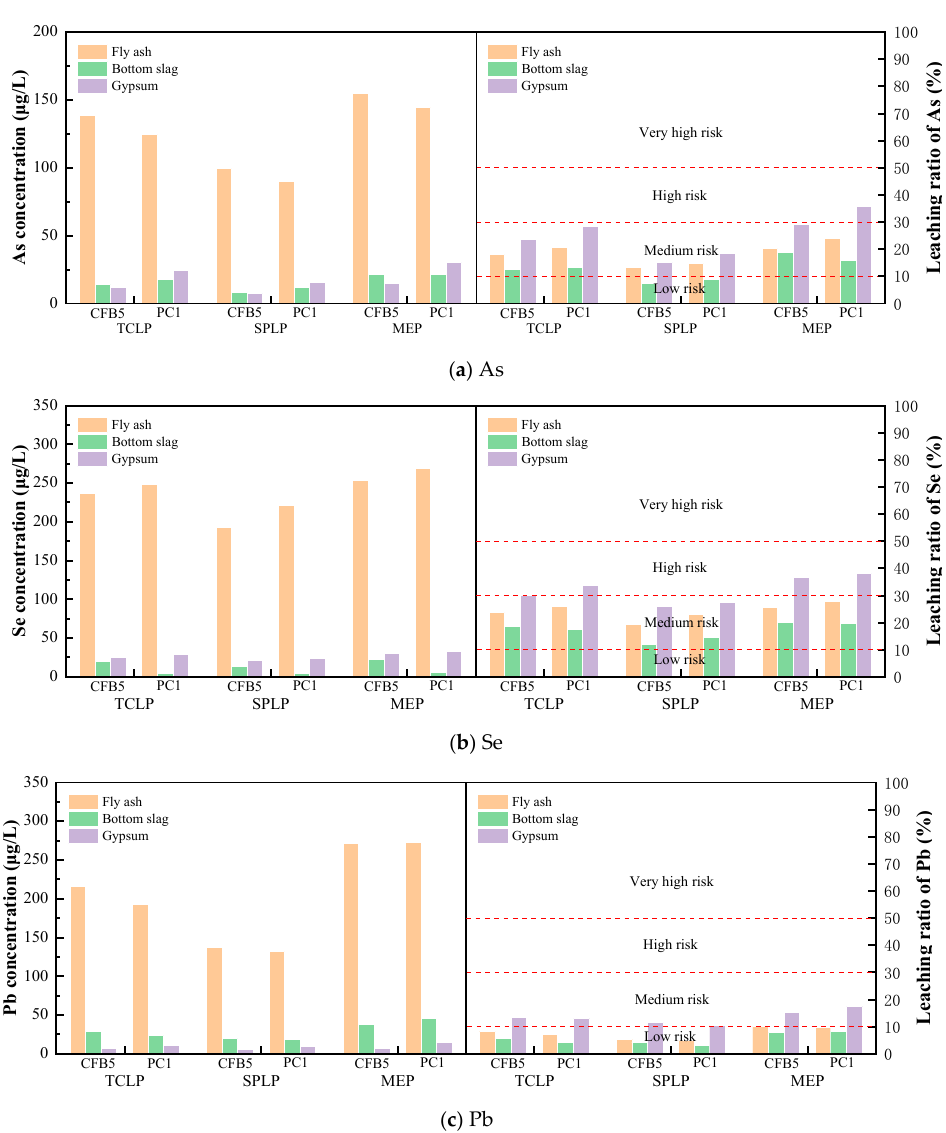
Figure 10. Leaching characteristics of As, Se and Pb in combustion by-products of CFB5 and PC1.